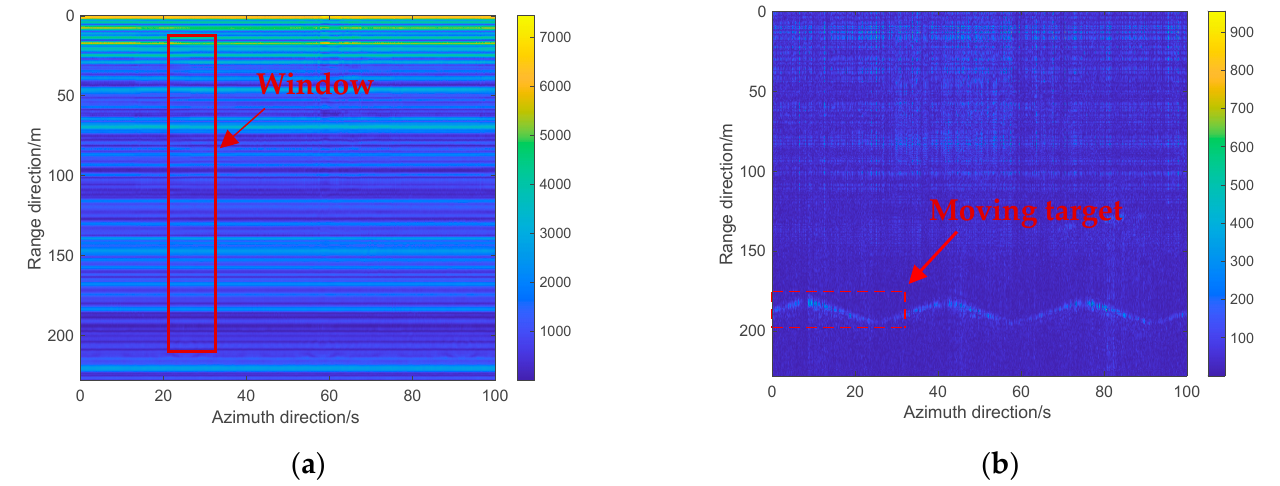
Figure 6. 2D range profiles. ( a ) Before the removal of background. ( b ) After the removal of back- ground.